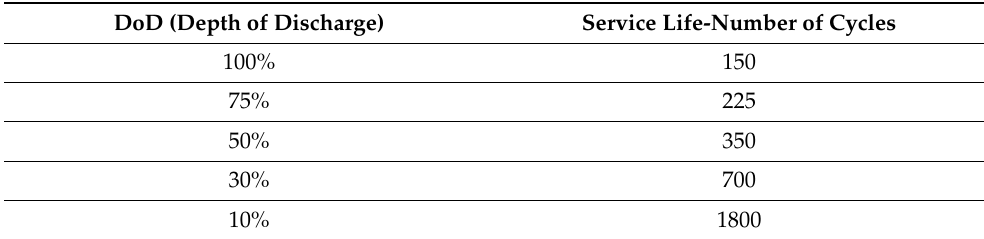
Table 2. Relational discharge level and service life in terms of number of traction battery CCs